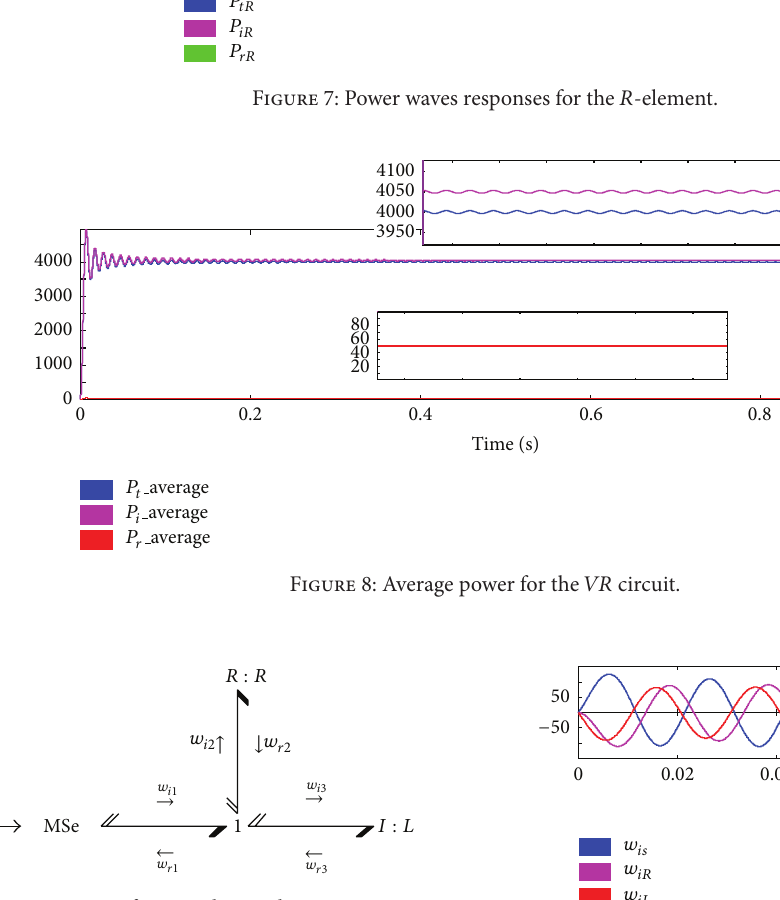
Figure 9: StBG of a VRL electrical circuit.